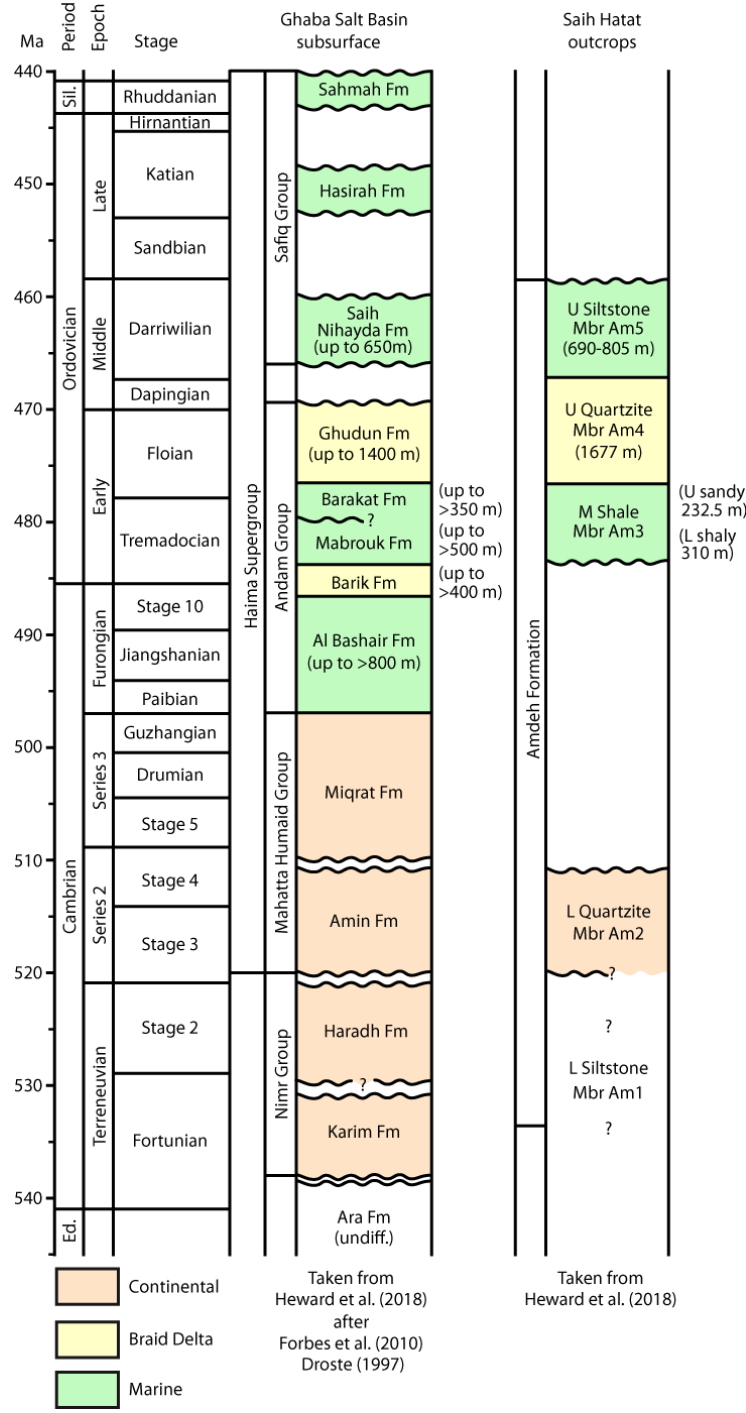
Figure 2. Lateral correlation of the Amdeh Formation (Saih Hatat Dome) with lithologically similar units in the subsurface of Oman (Ghaba Salt Basin), drawn after [5]. Note that the correlation of Am 1 is less certain than that of Am 2–Am 5.